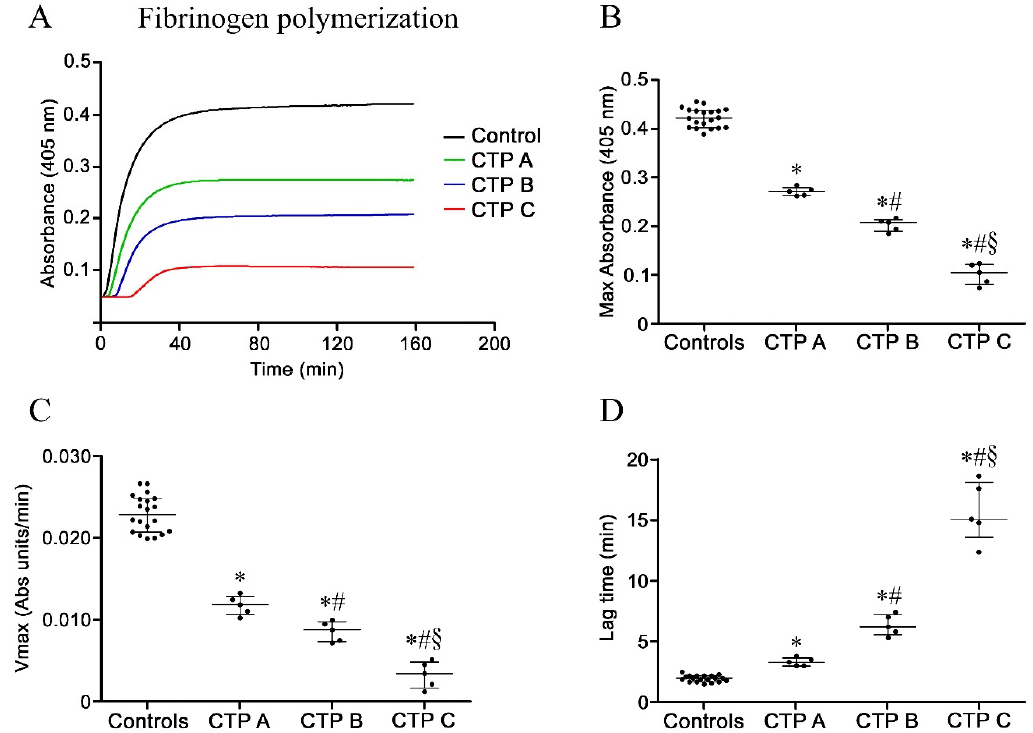
Figure 3. Fibrinogen polymerization experiments. ( A ) Representative curves of thrombin-catalyzed fibrinogen polymerization and corresponding ( B ) Max Absorbance, ( C ) Vmax, and ( D ) lag time in fibrinogen purified from patients with liver cirrhosis at different disease severity ( n = 5 for each Child–Turcotte–Pugh category) and controls ( n = 20). Values are represented as median with interquartile range. *Significant difference vs. controls at the P < 0.05 level. # Significant difference vs. CTP A at the P < 0.05 level. § Significant difference vs. CTP B at the P < 0.05 level.